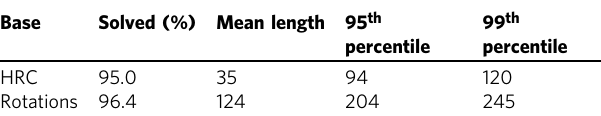
Table 3 Performance of the proximal policy optimization (PPO) and deep Q-learning (DQL) agents in approximating Haar unitary matrices. The performances are measured after the training procedures over a validation set of 10 6 targets. We exploit the Harrow-Recht-Chuang ef fi cient base of gates (HRC) and the rotations gates. The 95 th and 95 th columns refer to the 95 th and 95 th percentile of the distribution of the length of the solved